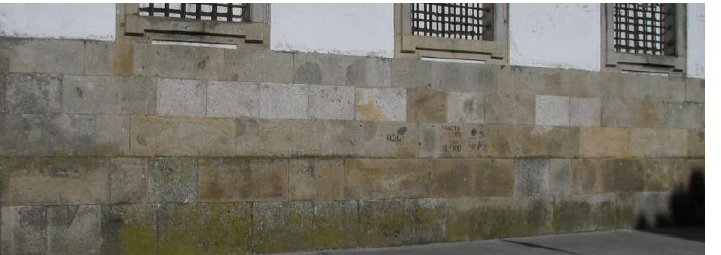
Figure 8. A wall with regular distribution of regular shaped stones (it is possible to define referencing for locating individual stones and individual features inside a given